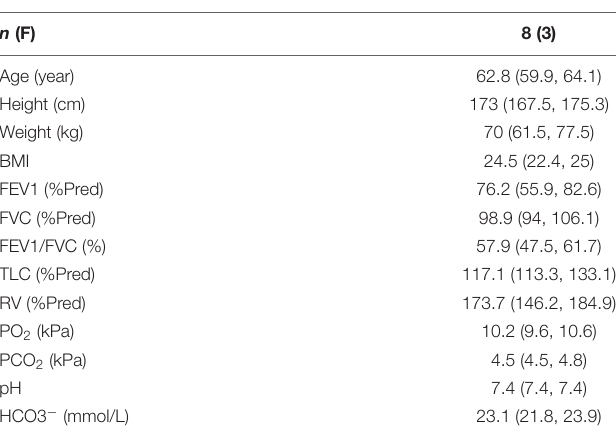
TABLE 1 | Subject